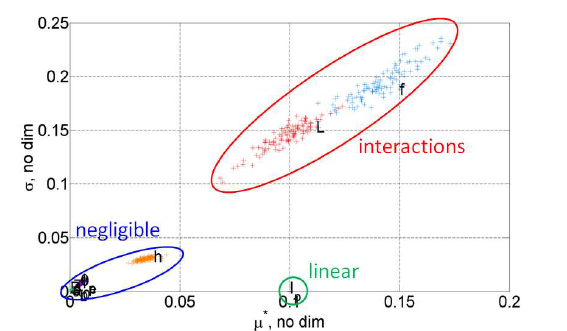
Figure 12: Influence of L parameter